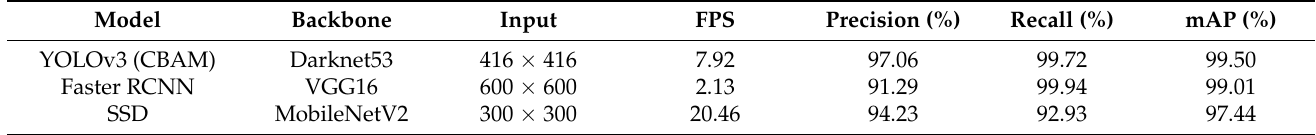
Table 4. Comparison of detection results of different